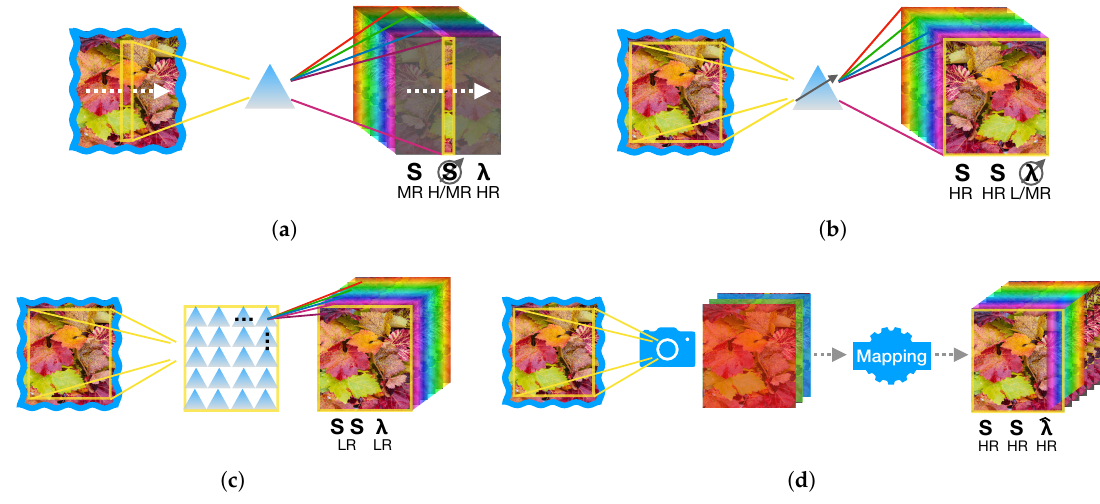
Figure 2. Basic schemes of HSI formation methods. H/M/LR: High/Medium/low Resolution. S: space, either x or y . λ : spectral dimension. ( a ) Pushbroom linear scanner. ( b ) Spectral selective acquisition. ( c ) Spectrally resolved detector array (snapshot). ( d ) HSI from RGB